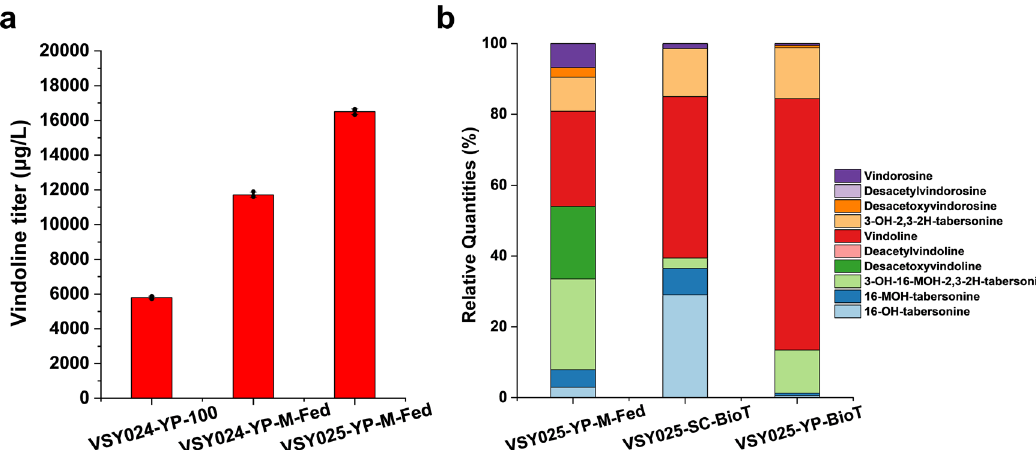
Fig. 7 Optimization of fermentation conditions for enhanced vindoline production in yeast. a Enhancing vindoline production in YP medium via feeding low concentration of tabersonine (~15 mg/L) every 24 h after galactose induction. A total of ~100 mg/L tabersonine was fed into the fermentation broth. Error bars represent SD of biological triplicates. b The accumulation of vindoline and intermediate metabolites in strain VSY025 by intermittent feeding of low concentrations of tabersonine and high cell density yeast biotransformation (BioT). Data are average of biological triplicates ( n =